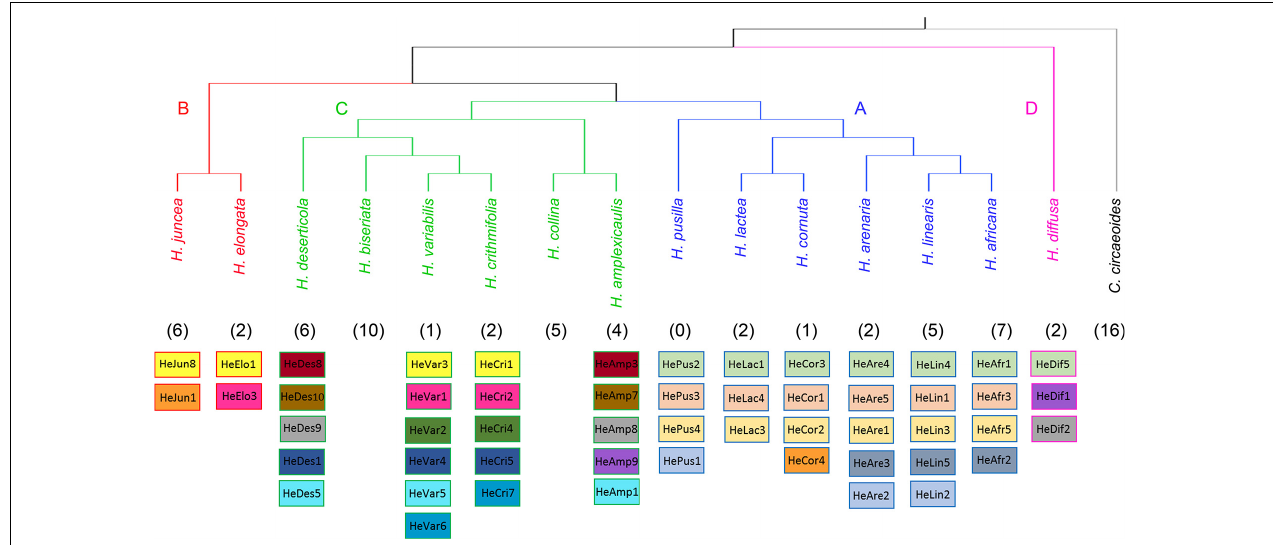
FIGURE 4 | Overview of shared tandem repeats among the 15 Heliophila species analyzed. The ITS tree ( Supplementary Figure 2 ) was used to display species relationships. Shared tandem repeats are color-coded; numbers of species-specific tandem repeats are indicated in parenthesis.